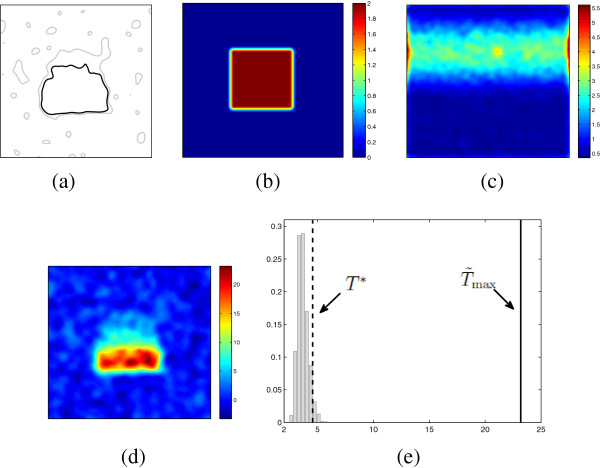
Permutation test procedure with simulations. (a) The identified region with p < 0.05, through a voxel-by-voxel based t-test (gray contour) and the permutation test (black contour). (b) The average dose difference map
d~k (k = 1,…,128×128) for the observed sample. (c) The SD σk of the dose difference, computed from 1000 permutated random samples. (d) The normalized dose difference map
T~k for the observed sample, which is (b) divided by (c). (e) The distribution of Tmax,i from i = 1,…,1000 permutation samples, where
T~max is the maximum value in figure (d) and T∗ is the 95 percentile of Tmax,i.